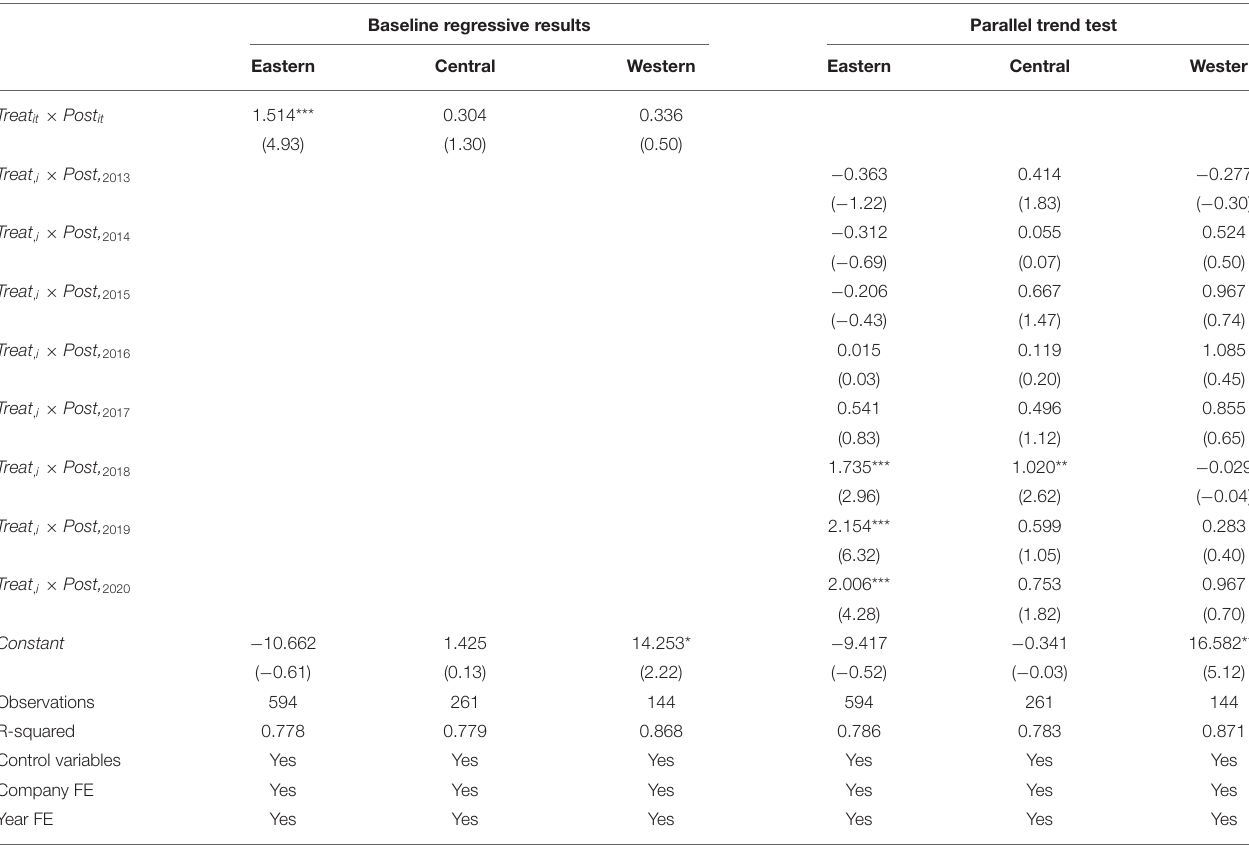
TABLE 7 | Results of the regional distribution heterogeneity